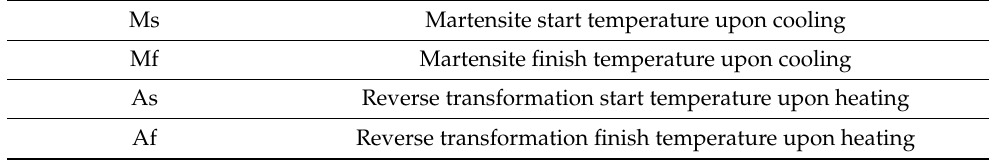
Table 1. Characteristic temperatures of